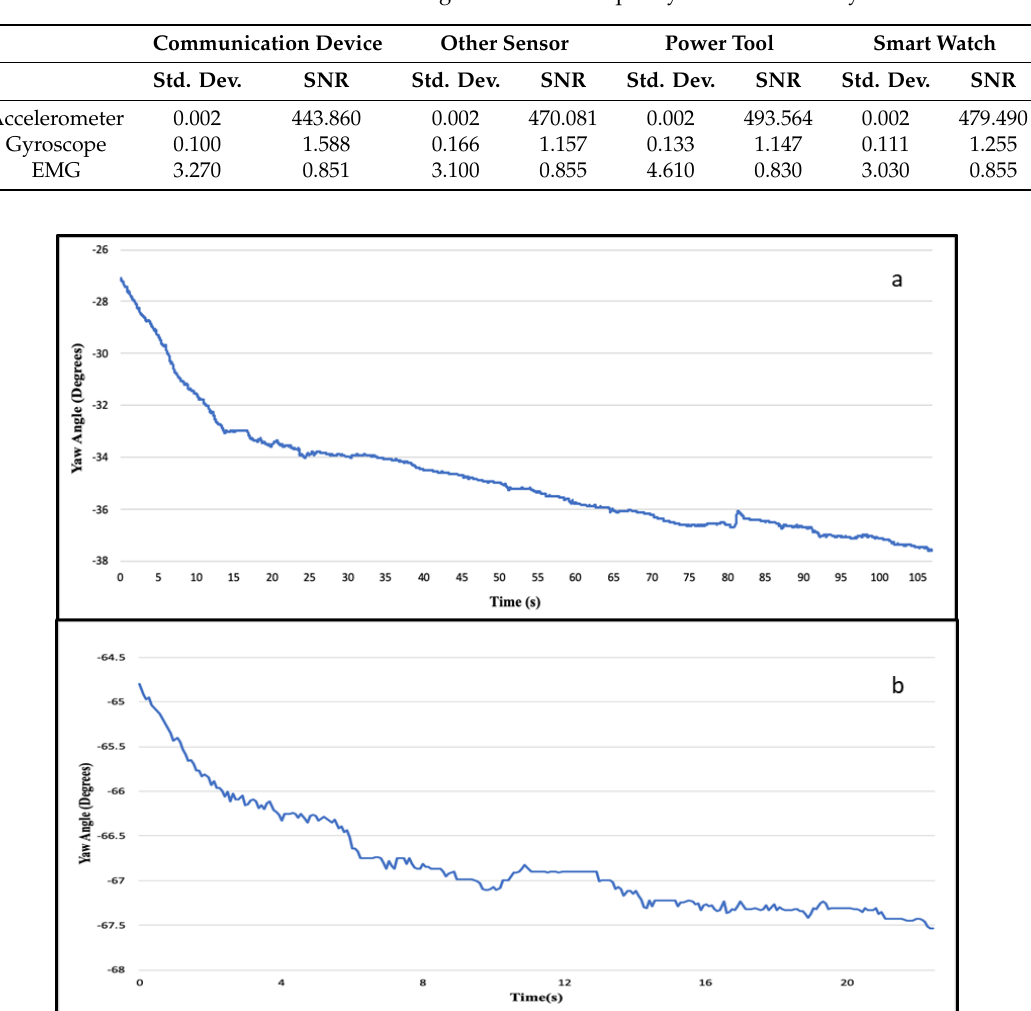
Figure 4 . Evolution of yaw angle of armband sensor while ( a ) stationary on the body and ( b ) lying on the floor.